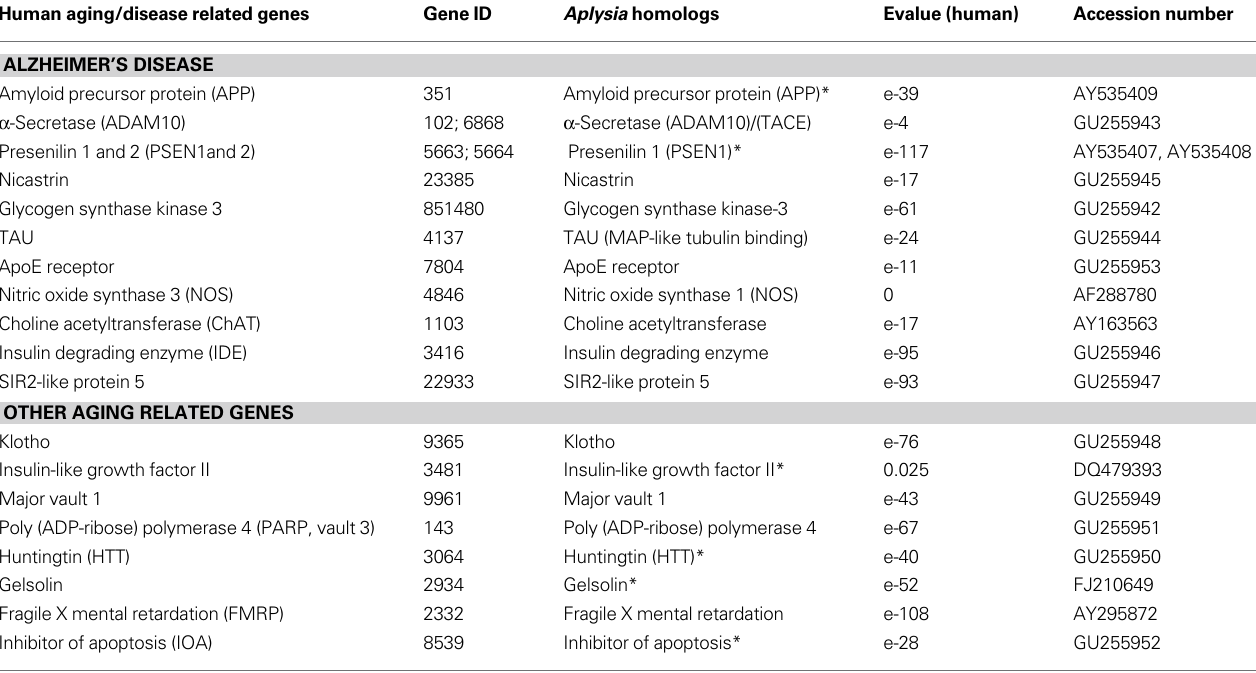
Table 1 | Identifi ed Aplysia homologs of genes involved in Alzheimer’s disease and aging (human GeneIDs were obtained from OMIM ® Online Mendelian Inheritance in